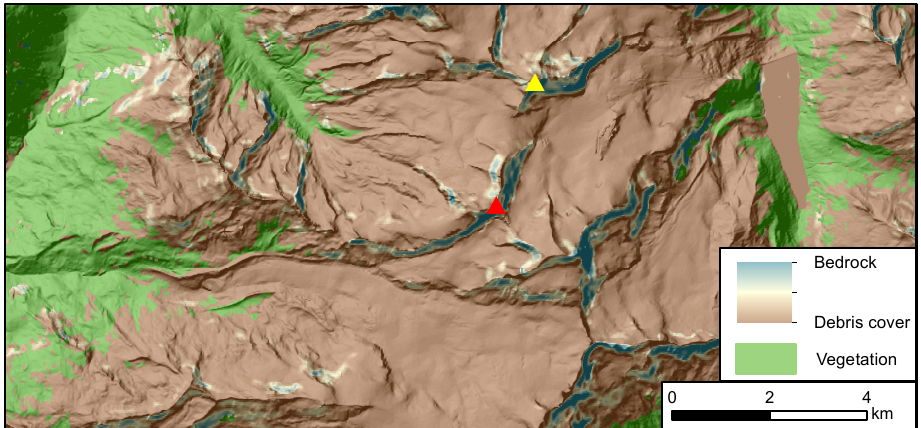
Fig. 6. Surface cover map showing the vegetation mask and the surface class index m r (Eq. 1) for the same area as Fig. 5. To grid cells with a slope angle ≤ 35 ◦ the debris model, for slope angles ≥ 55 ◦ the rock model is used. In between, a fuzzy membership (linear function depending on slope angle) is applied in order to provide a complete spatial coverage of APIM.